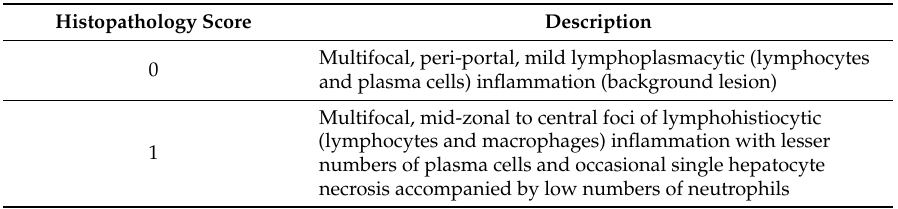
Table 1. Liver histopathology score